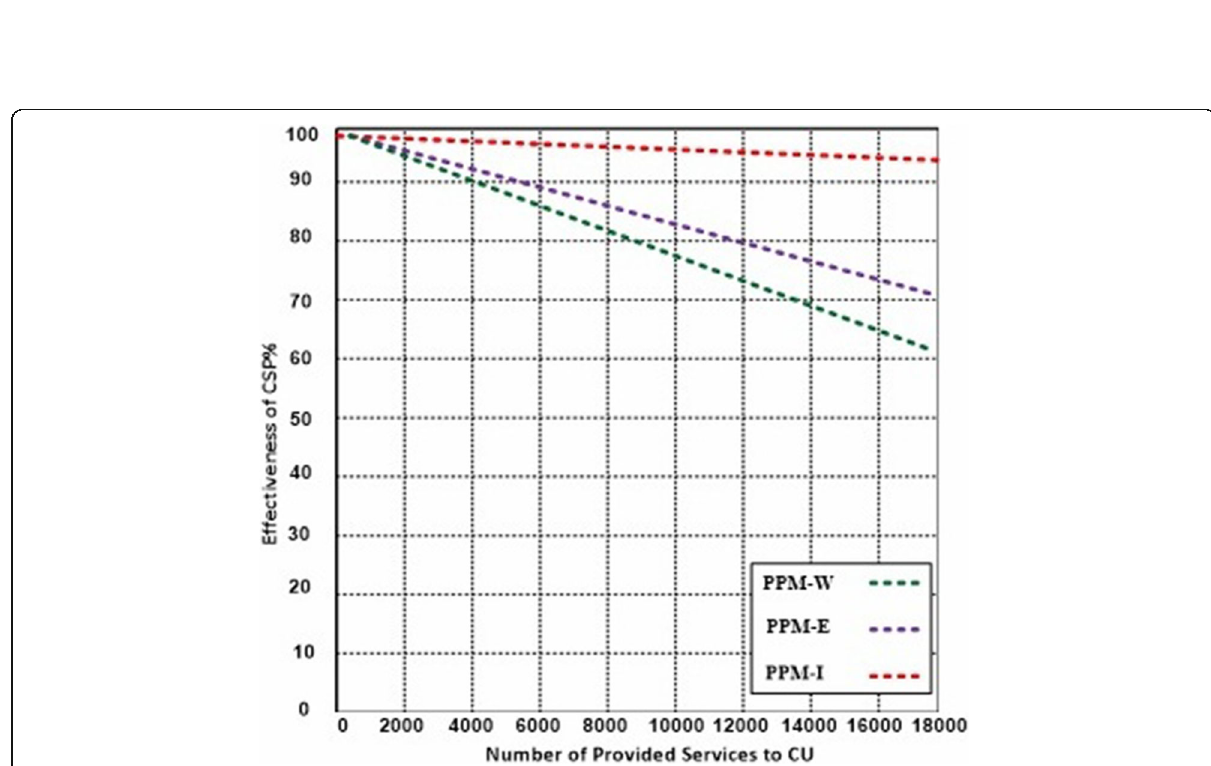
Fig. 8 Effectiveness of CSP VS relatively larger number of services to Cloud